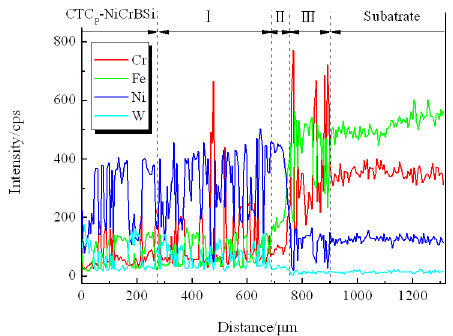
Figure 12. EDS line scan from unmodified CTC P -NiCrBSi to substrate.